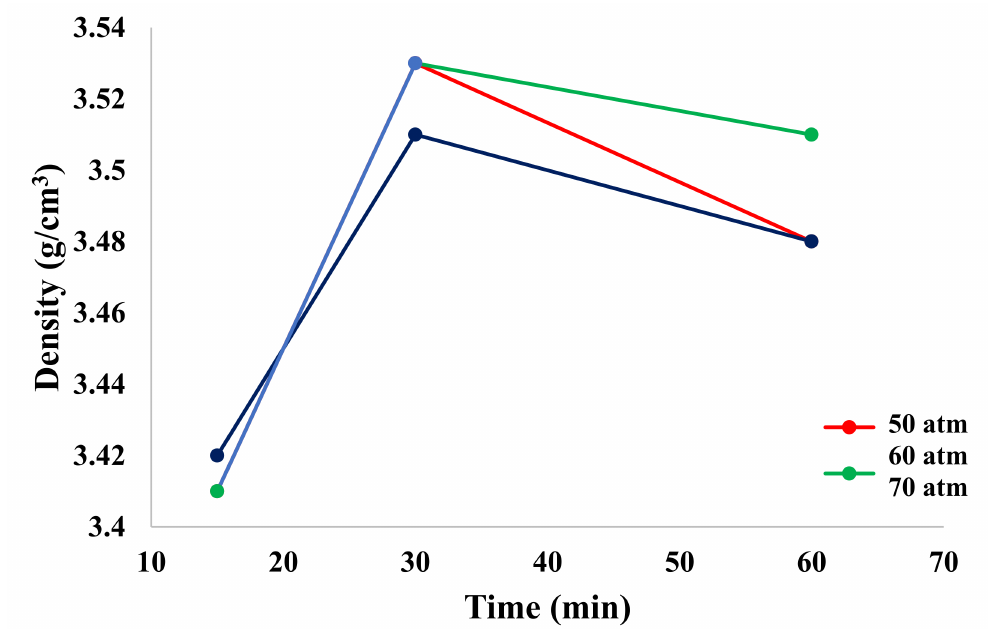
Figure 4. Dependence of density on pressure and process time. After measuring the density and specific surface area with the BET method, it was found that 30 min was the optimal process time, as both parameters (density and specific surface area) were characterized by the highest